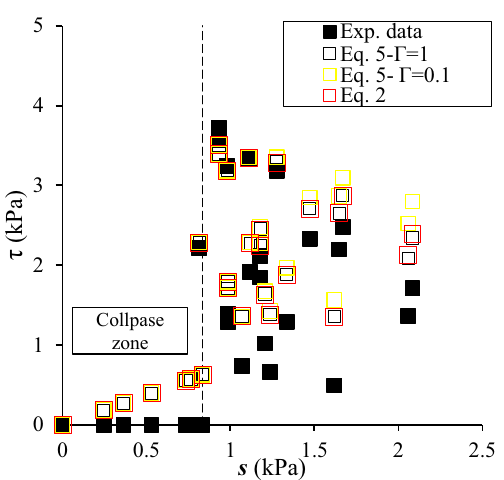
Fig. 5 Evaluation of the effective degree of saturation for the unconfined compression test results for sand